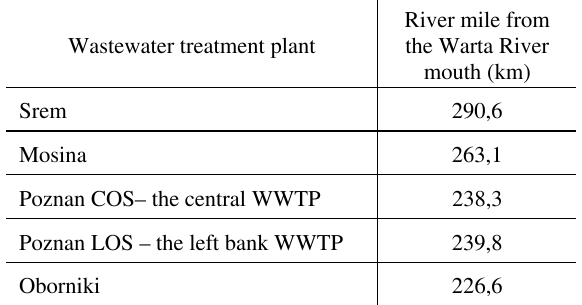
Table 2. Wastewater treatment plants (WWTP) discharges into the Warta River included in the study Wastewater treatment plant